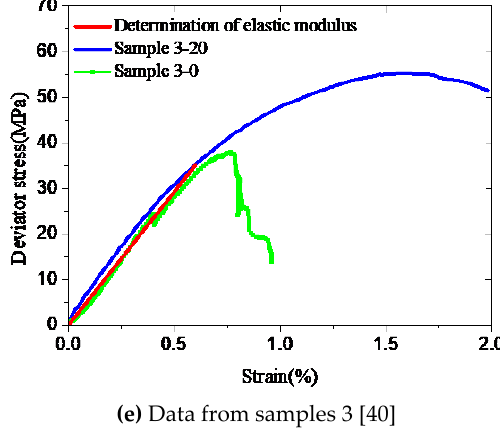
Figure 4. Determination of σ p 0 based on uniaxial tests. 3.1.2. Determination of the Ultimate Strength f c0 and the Corresponding Strain ε c0 After the linear elastic phase, as the cement approaches its unconfined ultimate strength, micro- cracks develop and grow to the extent that the Poisson ratio can no longer describe the relationship 0.0